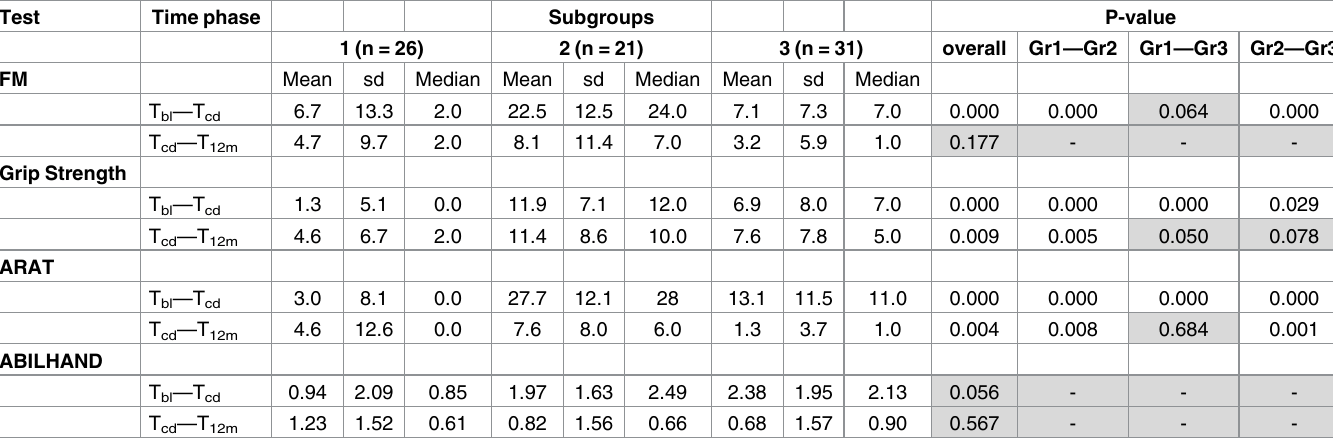
Table 3. Rate of improvement over time (mean, sd, median) of patients regarding FM, ARAT, grip strength and ABILHAND. Test Time